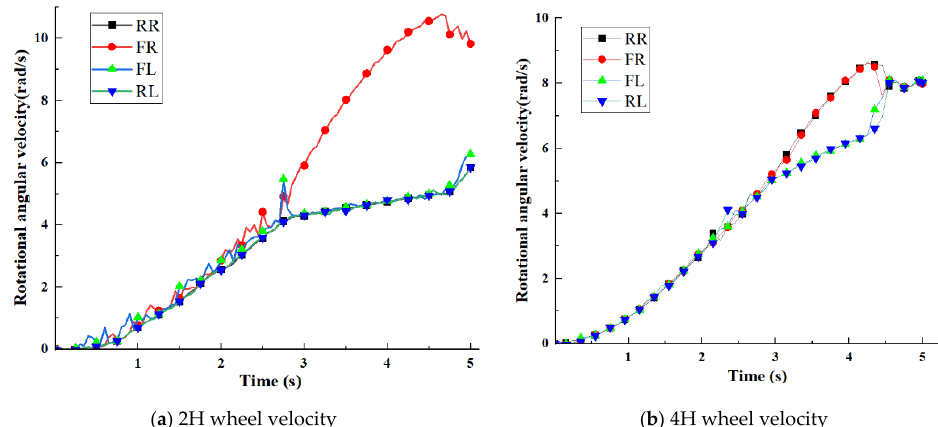
Figure 18. Opposite road test wheel speed data.